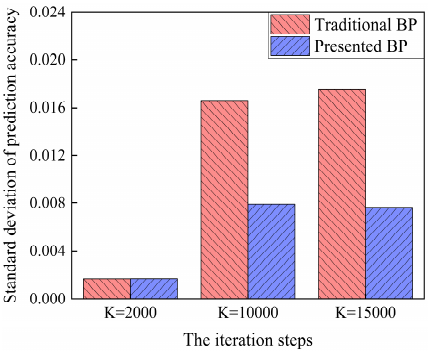
Figure 11. Figure 11. Comparison of prediction standard deviations of the traditional model and the presented model.